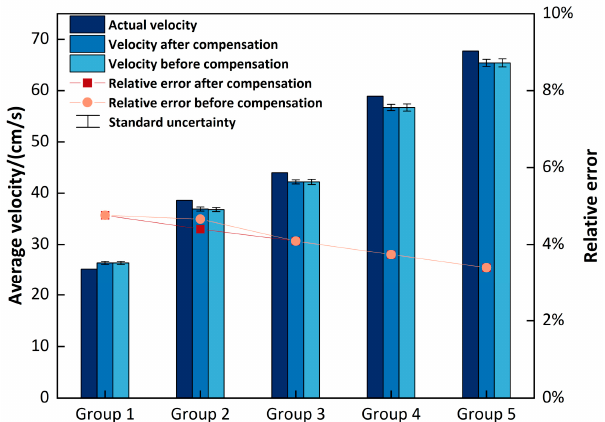
Figure 17. Statistical analysis of blood flow average velocity, relative error, and standard uncertainty results detected by the system at different flow rates.